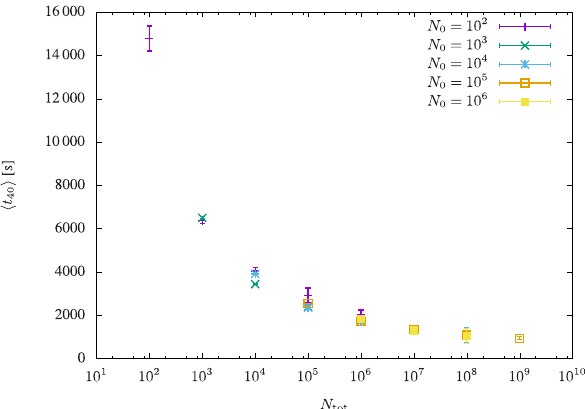
Figure 10. Mean time until a system of N tot droplets produces the first droplet with r = 40µm. The system is divided into coalescence cells of size N 0 . The figure is based on the results of “one-to-one” simulations given in Table